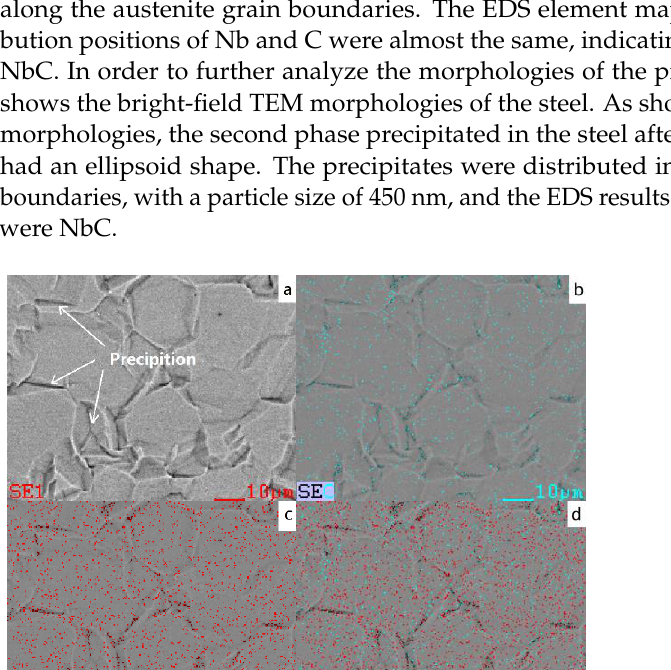
Figure 6. Transmission electron microscopy (TEM) bright-field morphologies and EDS analysis of Fe – 28Mn – 10Al – C – 0.5Nb steel. 3.2. Stacking Fault Energy Al has a great influence on the stacking fault energy (SFE) of Fe – Mn – Al – C low den- sity steel. SFE determines the deformation mechanism of low-density steel [23,24], so will therefore affect the mechanical properties. Based on the thermodynamic model estab- lished by Olson – Cohen [25], the SFE( τ ) can be estimated as: τ = 2 ρ ∆G γ → ε + 2 σ